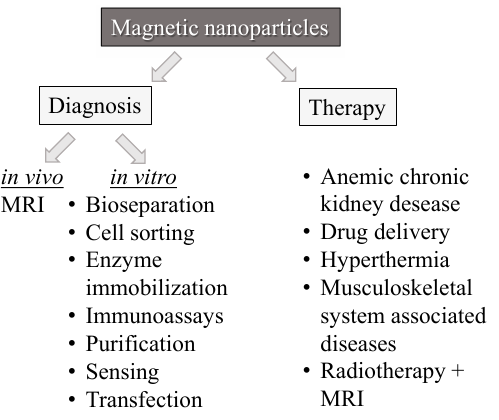
Figure 5. Magnetic nanoparticles in biomedicine: diagnosis and therapy (adapted from [35]).